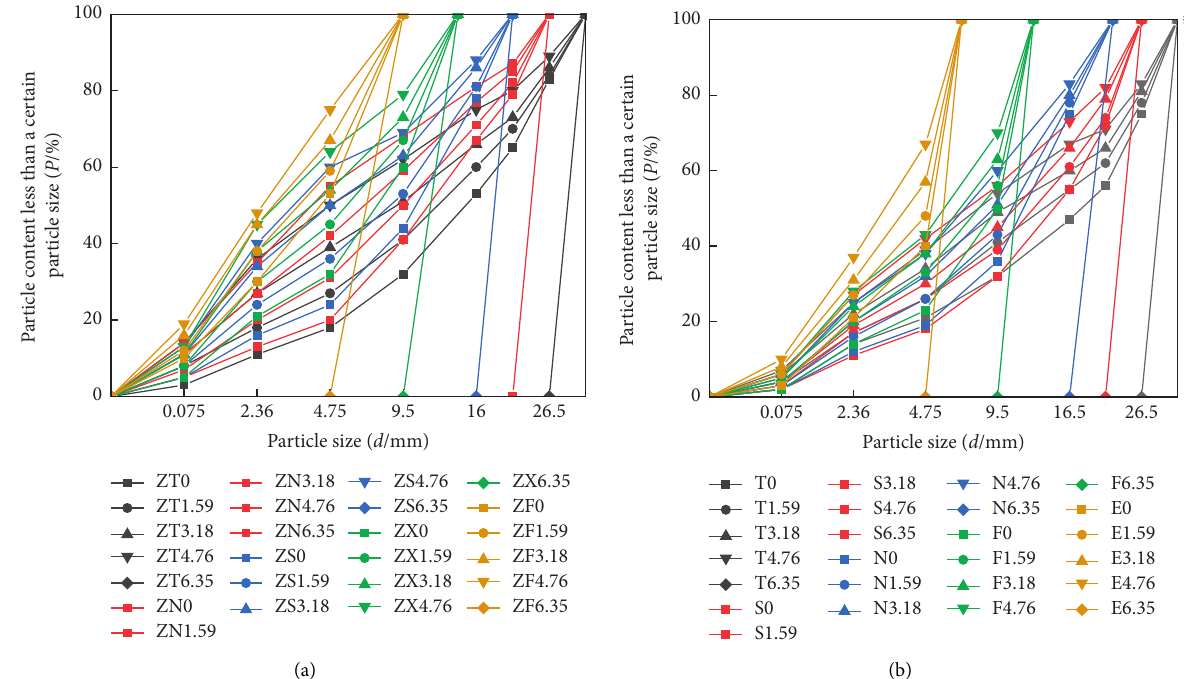
Figure 9: Gradation curve of each particle group under different cumulative energy. (a) Gradation curve of recycled brick. (b) Gradation curve of recycled concrete